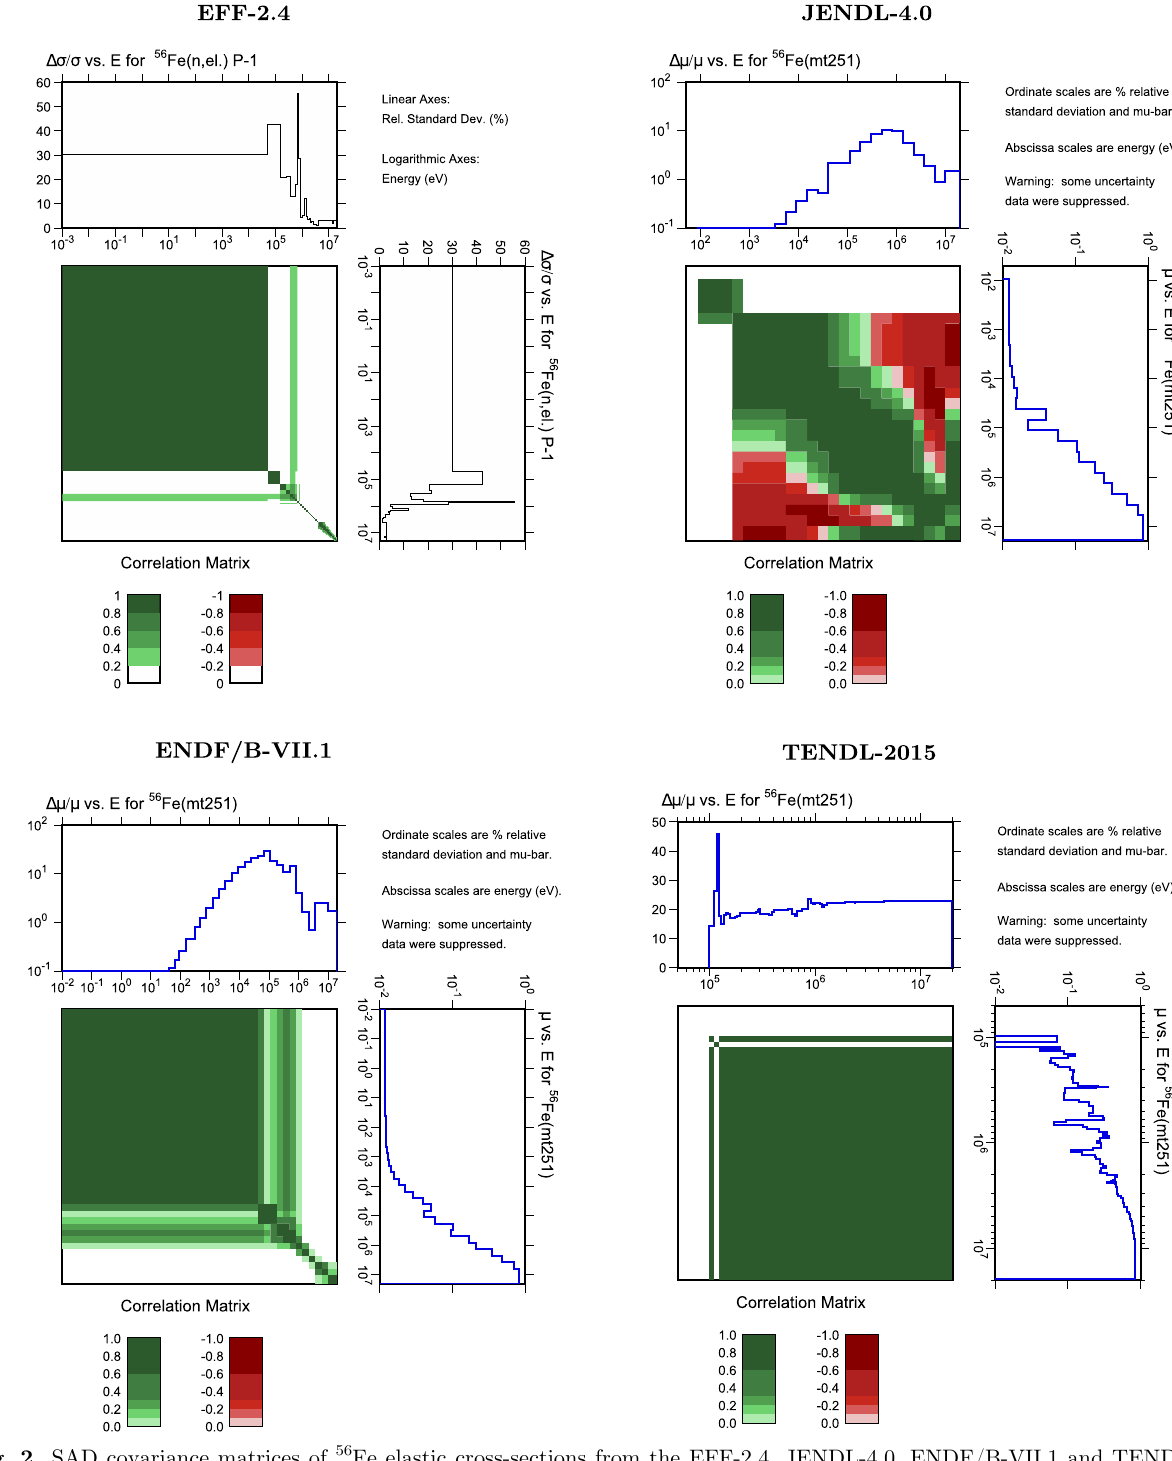
Fig. 2. SAD covariance matrices of 56 Fe elastic cross-sections from the EFF-2.4, JENDL-4.0, ENDF/B-VII.1 and TENDL-2015 evaluations. Warning: apparent similarity between the JENDL-4.0 and ENDF/B-VII.1 covariances is only an artifact of log/log scale which is for some reason used in the recent versions of NJOY. Switching back to the old (much more informative) lin/log presentation is strongly recommended (e.g. by rede fi ning the “ yrtest ” parameter in the COVR